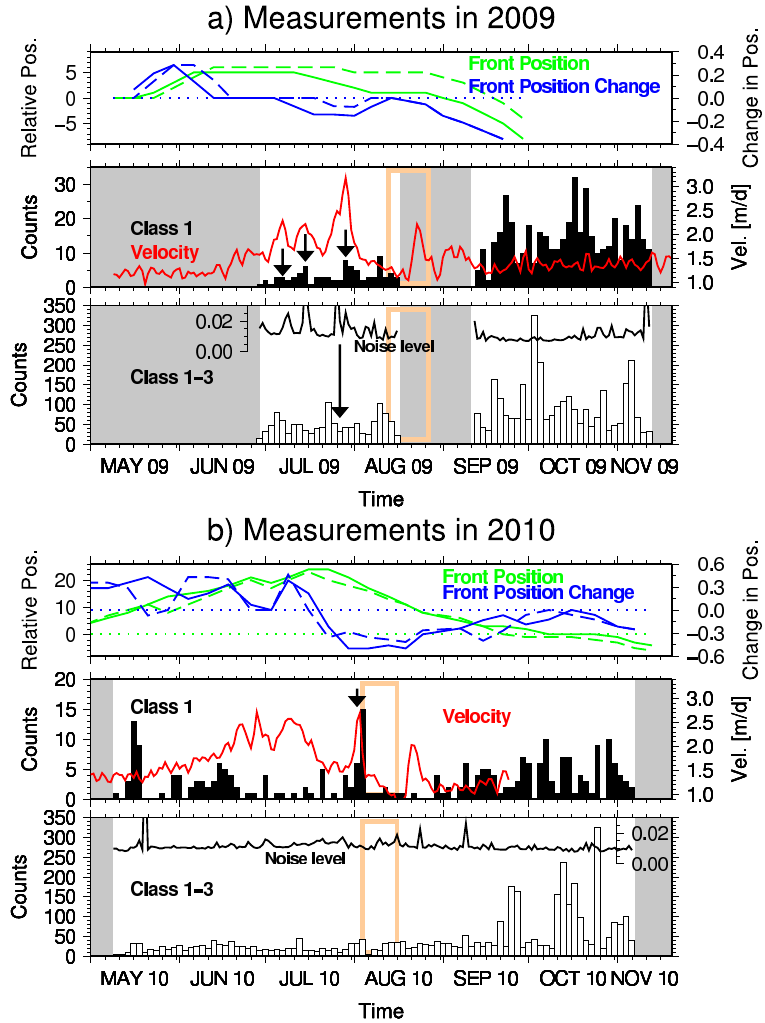
Fig. 6. (a) Lower panel: temporal distribution of seismic detections belonging to event classes 1 to 3 in 2009. Noise level in seismic data is shown using amplitude units in Volt. Grey areas represent data gaps and orange boxes periods of direct (visual) calving observations. Middle panel: same for Class 1 only (seismic events related to iceberg calving). Red curve shows velocity of Kronebreen measured close to calving front. Arrows indicate short-term correlations between GPS velocity, noise level, and event rate. Upper panel: green curve represents average, relative position and blue curve change in front position of entire front. Dashed lines indicate front position and change only in Zone 1. Horizontal, green-dotted curve shows position at first day of measurement in spring for each year and blue-dotted curve no change in front position (zero). Between October 2009 and May 2010, front position advanced as observed in field and from images. Note that zero reference in top panel of (a) and (b) vary between years. Positive values correspond to advance and negative to retreat of front. (b) Same as in (a) for 2010. Scale for Class 1 counts is different for 2009 and